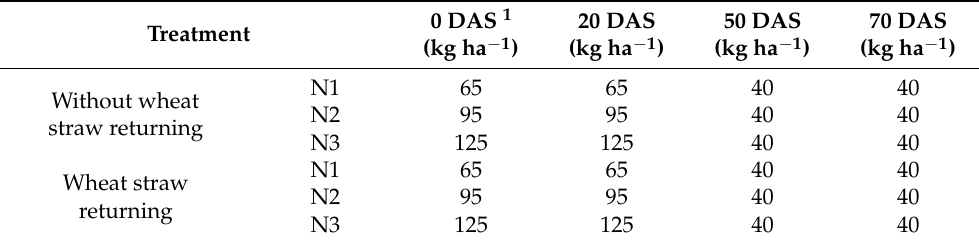
Table 1. Information on nitrogen application in this